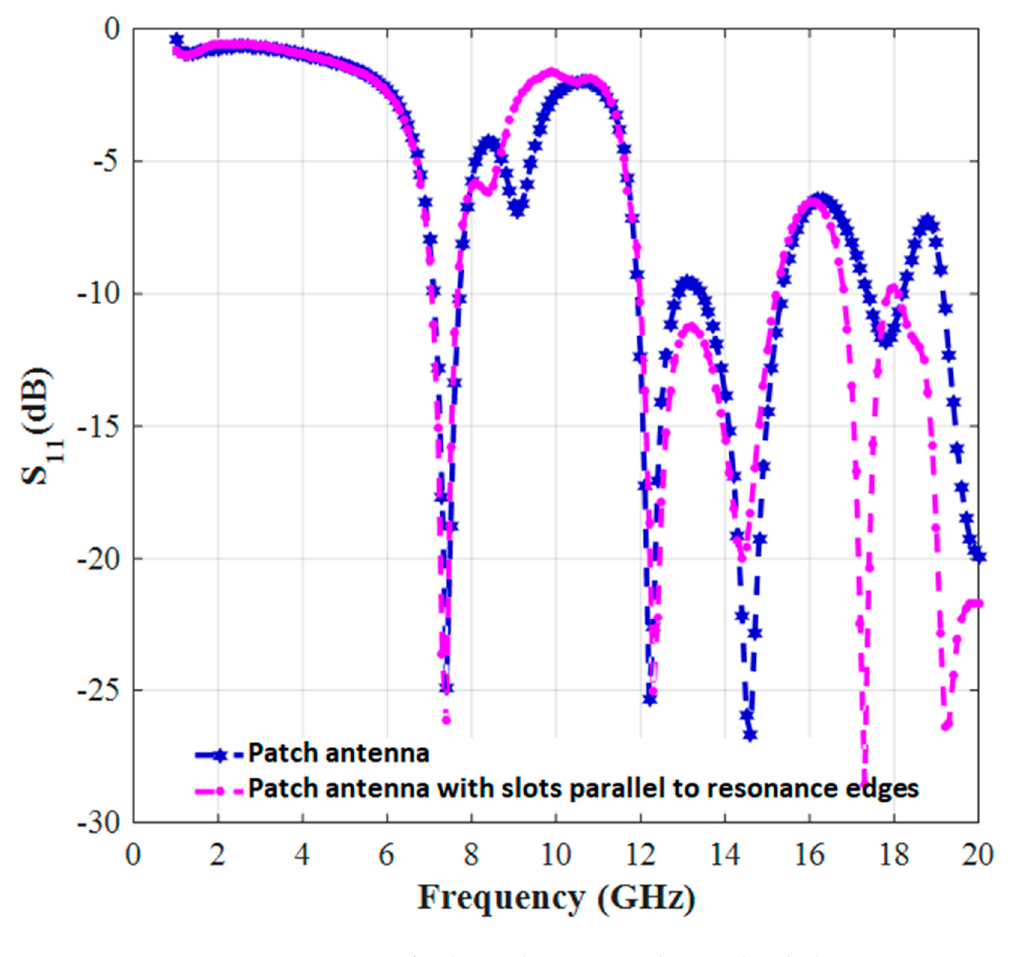
Figure 7. S11 parameters for the patch antenna without and with slots.